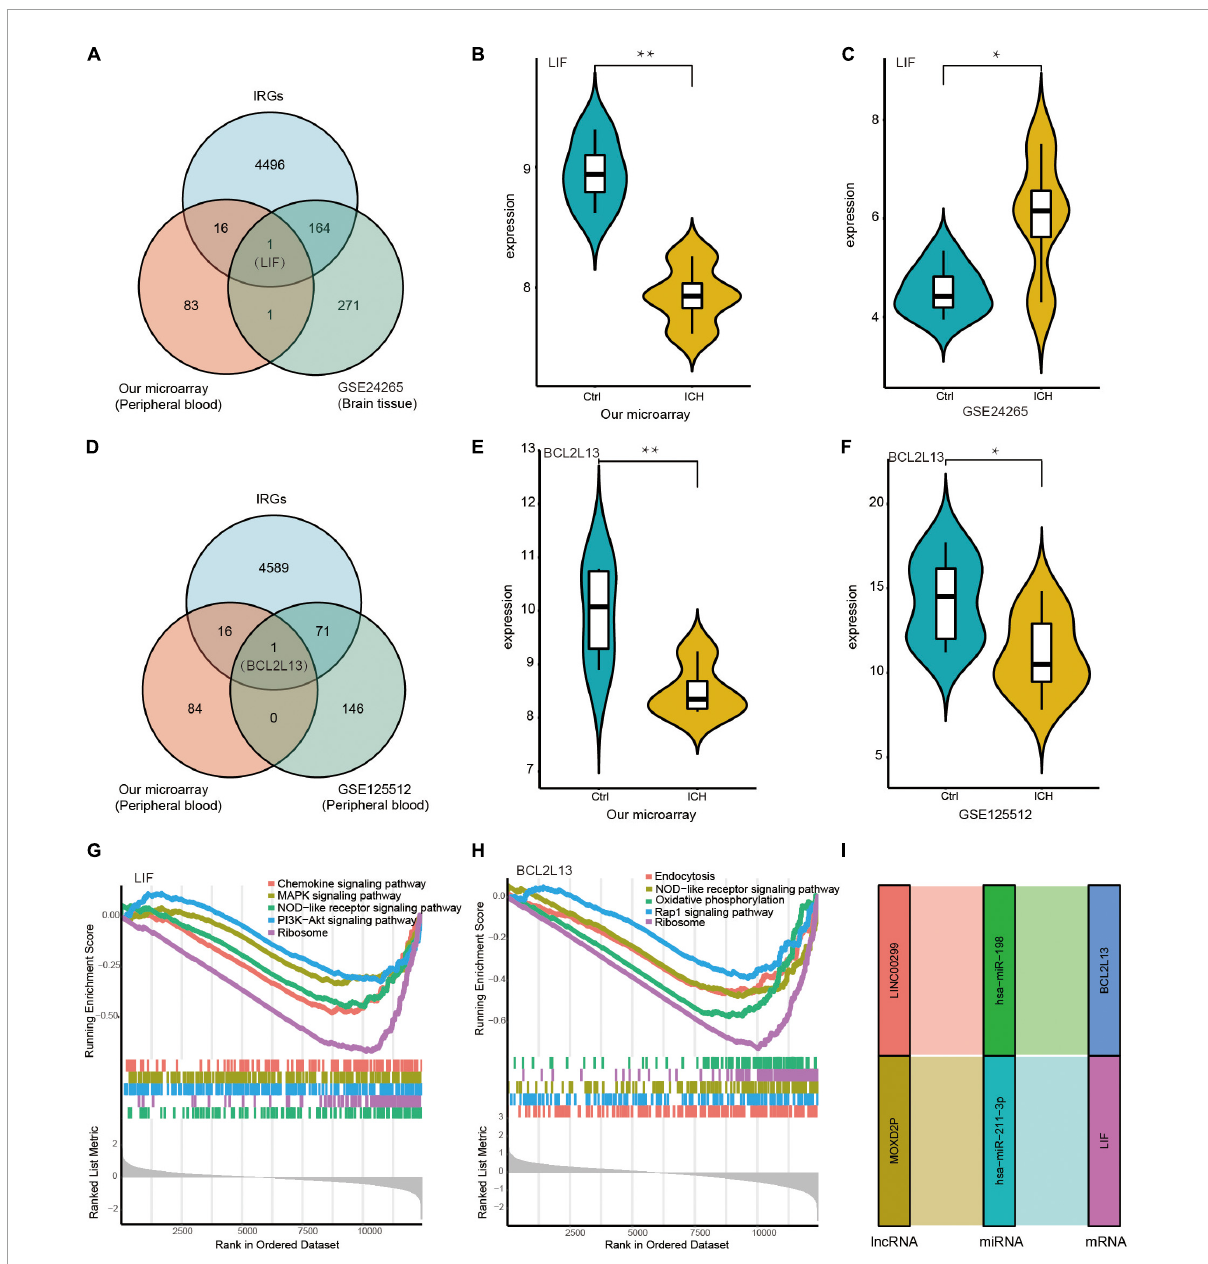
FIGURE8 Identification of key biomarkers and pathways of the immune-related DEmRNAs in the peripheral blood and the brain tissue from ICH patients. (A) The venn diagram showed LIF was at the intersection of the IRGs from immune database, the DEmRNAs in peripheral blood from our microarray, and the DEmRNAs in brain tissue from the GSE24265 dataset of ICH patients. (B) The expression of LIF in the peripheral blood from our ceRNA microarray. (C) The expression of LIF in the brain tissue from the GSE24265 dataset of ICH patients. (D) The venn diagram showed BCL2L13 was at the intersection of the IRGs from immune database, the DEmRNAs in the peripheral blood from our microarray, and the DEmRNAs in the peripheral blood from the GSE125512 dataset of ICH patients. (E) The expression of BCL2L13 in the peripheral blood from our ceRNA microarray. (F) The expression of BCL2L13 in the peripheral blood from the GSE125512 dataset of ICH patients. (G) The five representative results of GSEA for LIF. (H) The five representative results of GSEA for BCL2L13. (I) The immune-related ceRNA sub-network of LIF and BCL2L13, including MOXD2P-miR-211-3p-LIF and LINC00299-miR-198-BCL2L13. * P < 0.05, ** P <